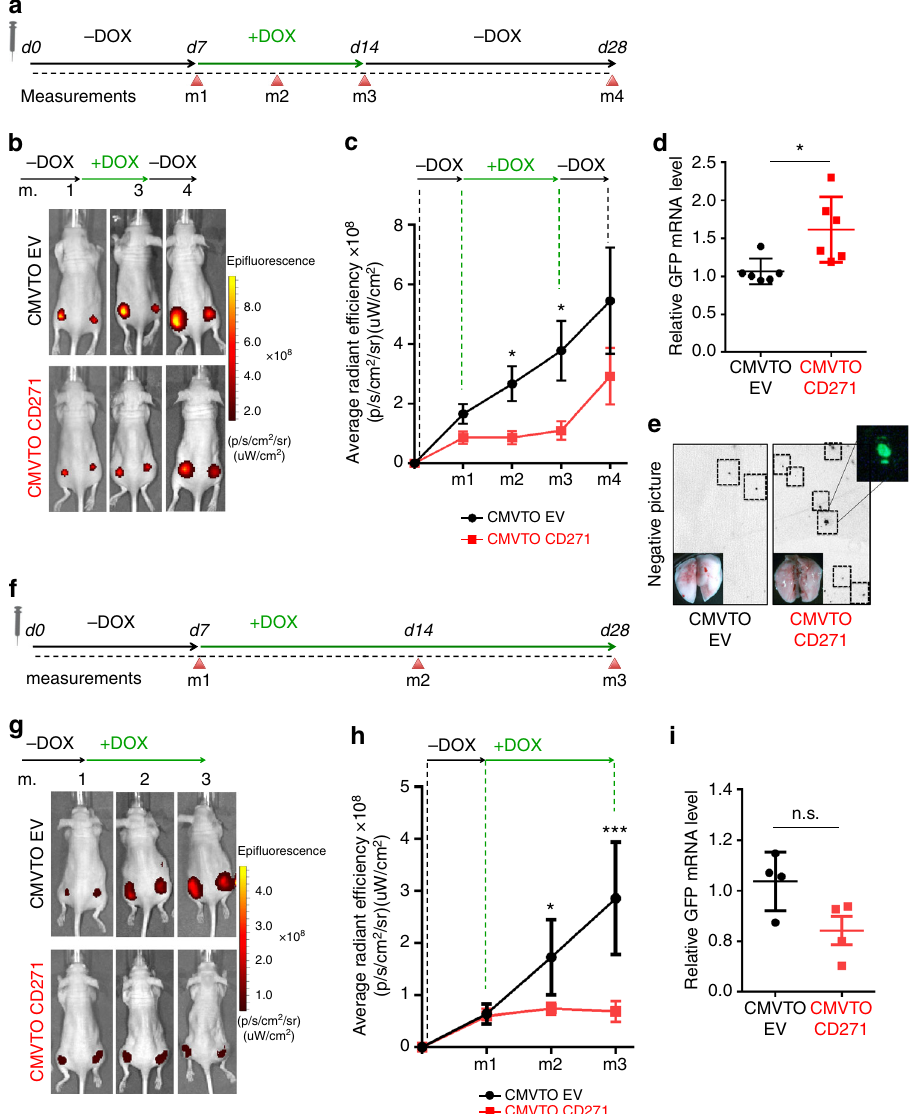
Fig. 5 Transient CD271 overexpression in vivo increases metastasis. a Time course for the transient CD271 expression experiment in vivo. At day 0 (d0) the mice were injected with melanoma cells carrying CMVTOEV or CMVTOCD271 vectors. 1 week after injection (d7), the mice were treated with 200 ng/ml of doxycycline for 1 week until day 14 (d14). The mice were then released from doxycycline and analyzed 2 weeks later (d28). Different measurements (m1, m2, m3, m4) were done by IVIS to check tumor growth at different time points. b In vivo imaging of Nude mice injected with cells carrying CMVTOEV or CMVTOCD271 vectors. m1 = start of doxycycline treatment; m2 = during doxycycline treatment; m3 = end of doxycycline treatment; m4 = 2 weeks after release of doxycycline. c Quanti fi cation of the IVIS signal for infrared protein (iRFP) (4 mice for a total of 8 injections were analyzed for both conditions; P value_m1 > 0.05, P value_m2 ≤ 0.05, P value_m3 ≤ 0.05, P value_m4 > 0.05). Error bars indicate S.E.M. d qRT-PCR for GFP transcripts in lung lysates of Nude mice treated according to a ( n = 6 for each condition. P value ≤ 0.05). Error bars indicate S.E.M. e Representative pictures of lungs at the end of the experiments to detect GFP. To enhance the visibility of the GFP spots, the pictures were set to grayscale and inverted. f Time course for the control experiment, in which CD271 expression was not switched. The experiment was designed as in a with the exception that between day 7 (d7) and day 28 (d28) the mice were not released from doxycycline but continuously treated. g In vivo imaging of Nude mice injected with cells carrying CMVTOEV or CMVTOCD271 vectors at different time points of the experiment (m1 = Start of doxycycline treatment; m2 = During doxycycline treatment; m3 = During doxycycline treatment). h Quanti fi cation of the IVIS signal for iRFP (4 mice for a total of 8 injections were analyzed for both conditions; P value_m1 > 0.05, P value_m2 ≤ 0.05, P value_m3 ≤ 0.001). Error bars indicate S.E.M. i qRT-PCR for GFP transcripts on lung lysates of Nude mice treated according to f . ( n = 4 for each condition P value > 0.05). Error bars indicate S.E.M. All experiments done with cell line M010817 metastases (Fig. 5e). In contrast, constant CD271 overexpression, CD271 expression promotes melanoma metastasis formation in starting with doxycycline administration one week after cell distant organs. injection (Fig. 5f), slowed down melanoma cell proliferation in vivo (Fig. 5g, h), as expected, but did not alter the amount of GFP-expressing cells in the lungs when compared to the lungs of Different signaling axes regulate proliferation and adhesion . control mice (Fig. 5i). These data demonstrate that a switch in CD271 is a single-pass transmembrane receptor that belongs to NATURE COMMUNICATIONS | 8: 1988 | DOI: 10.1038/s41467-017-01573-6 |